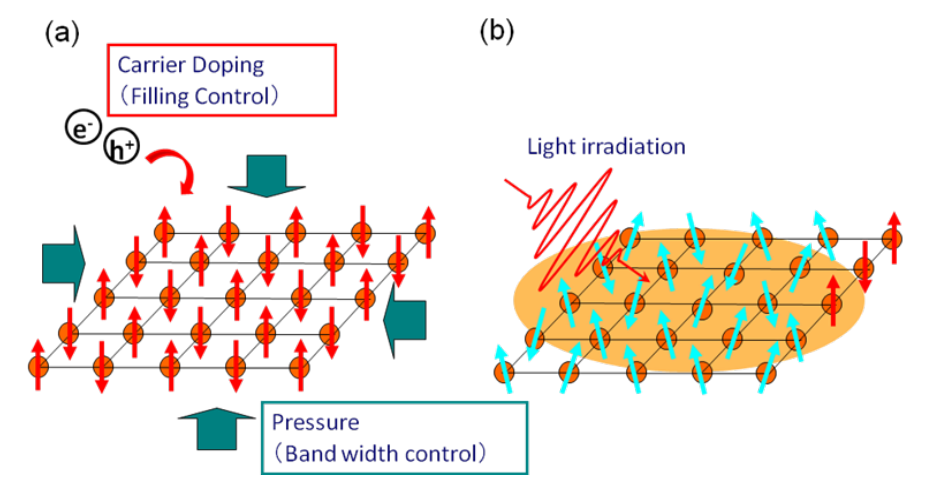
Figure 2. ( a ) Schematic illustrations of filling control (FC) and bandwidth control (BC) I–M transition and ( b ) the photoinduced I–M